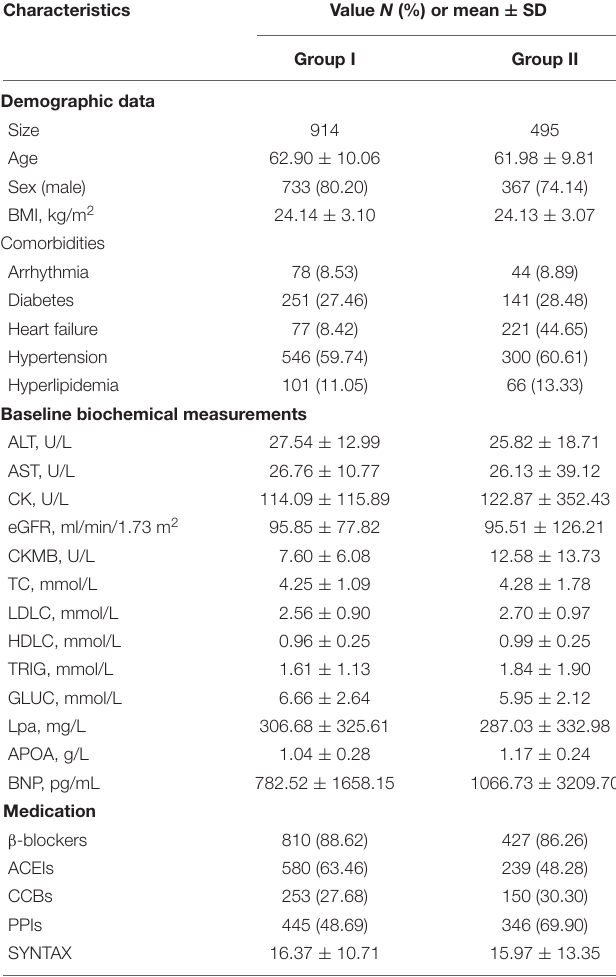
TABLE 1 | Baseline characteristics of the two